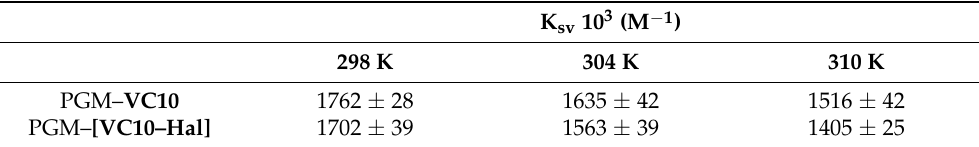
Table 1. Quenching constants of PGM in the presence of the quencher ( VC10 and VC10 – Hal ) at different temperatures.